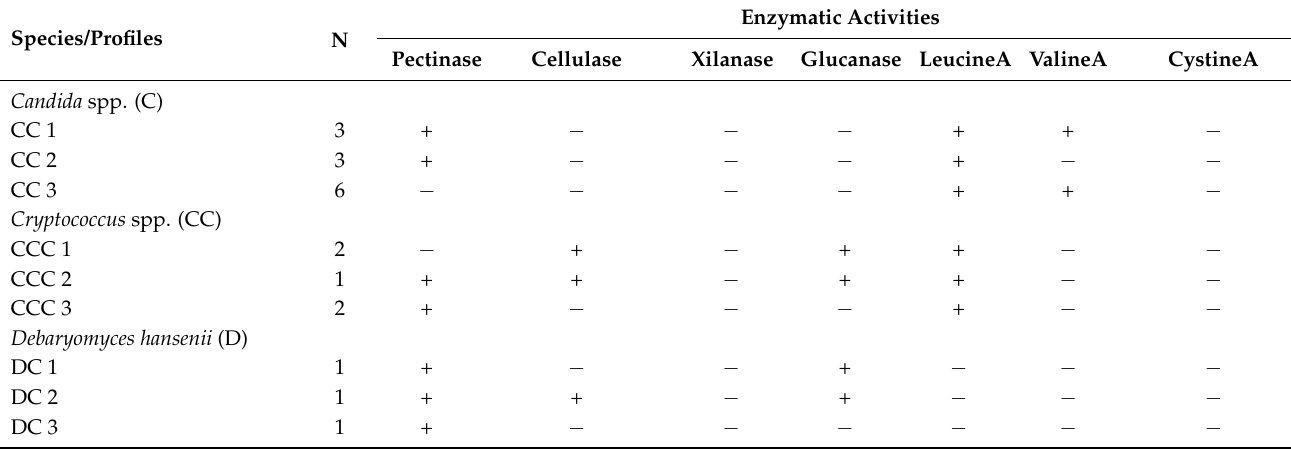
Table 2. Specific enzymatic profiles related to color and